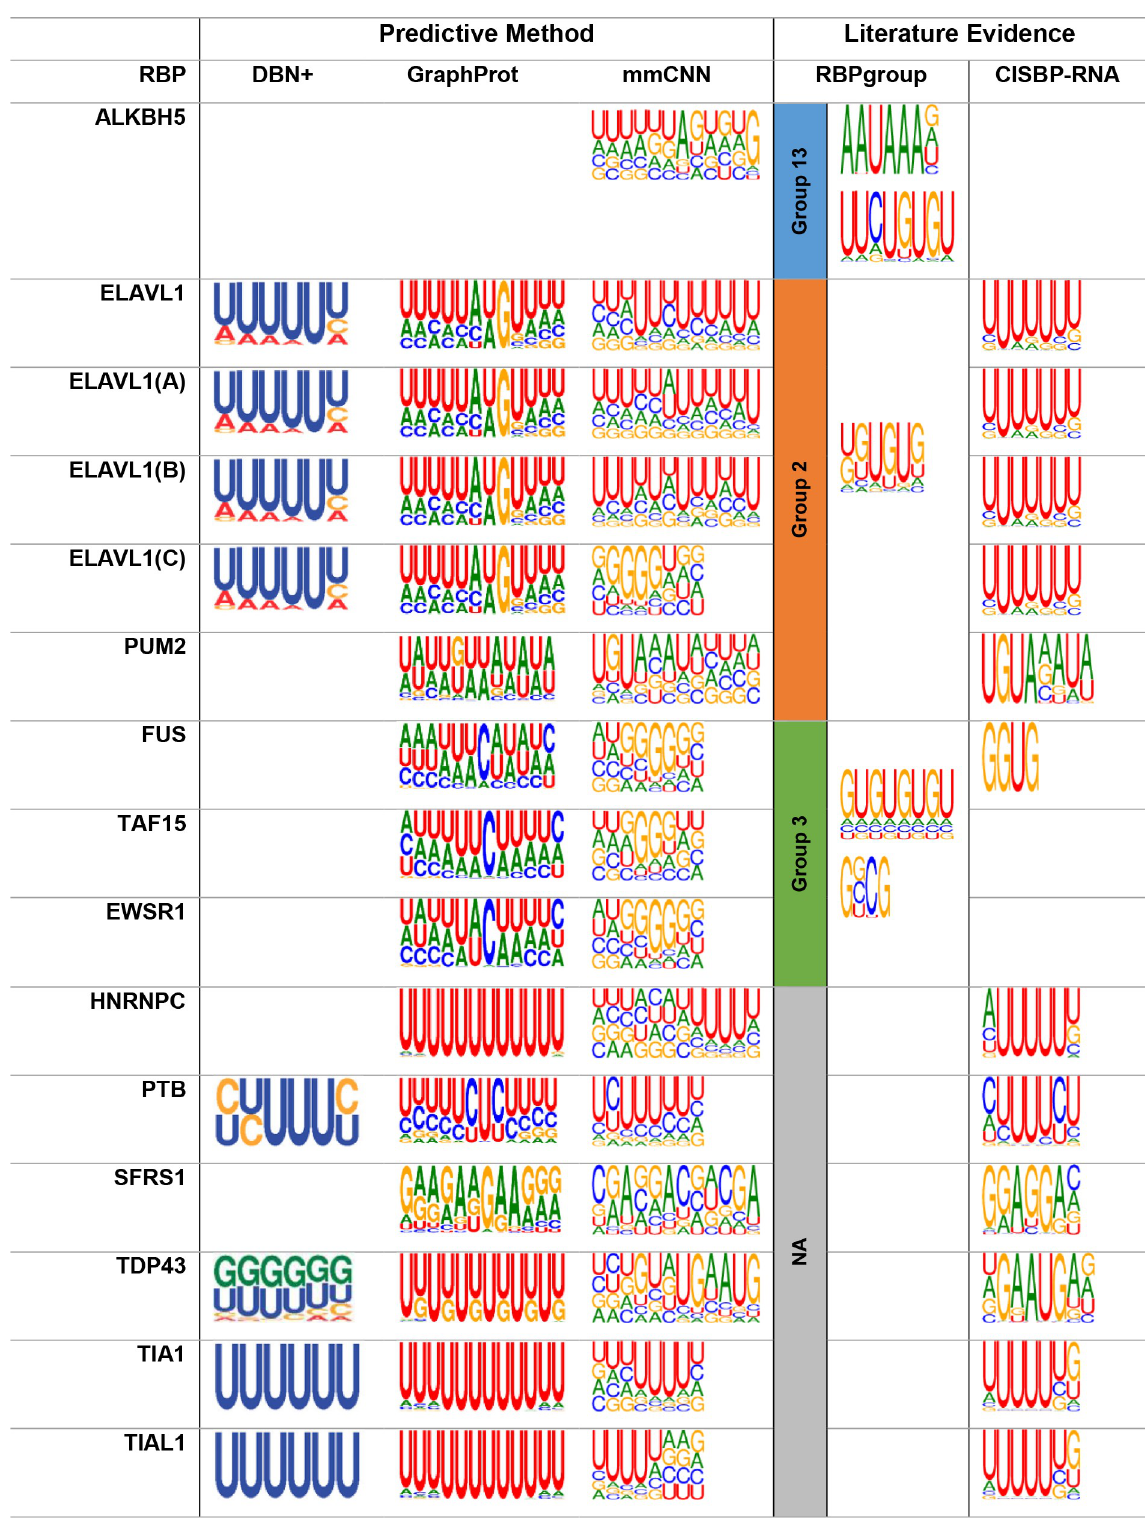
Fig 5. Sequence motif found by mmCNN and comparison with various researches. mmCNN was compared with two predictive method (DBN+ and GraphProt) and two other literature evidences (RBPgroup and CISBP-RNA). Since RBPgroup clustered different RBP families and found de novo motifs, individual groups found by RBPgroup was labeled in separate